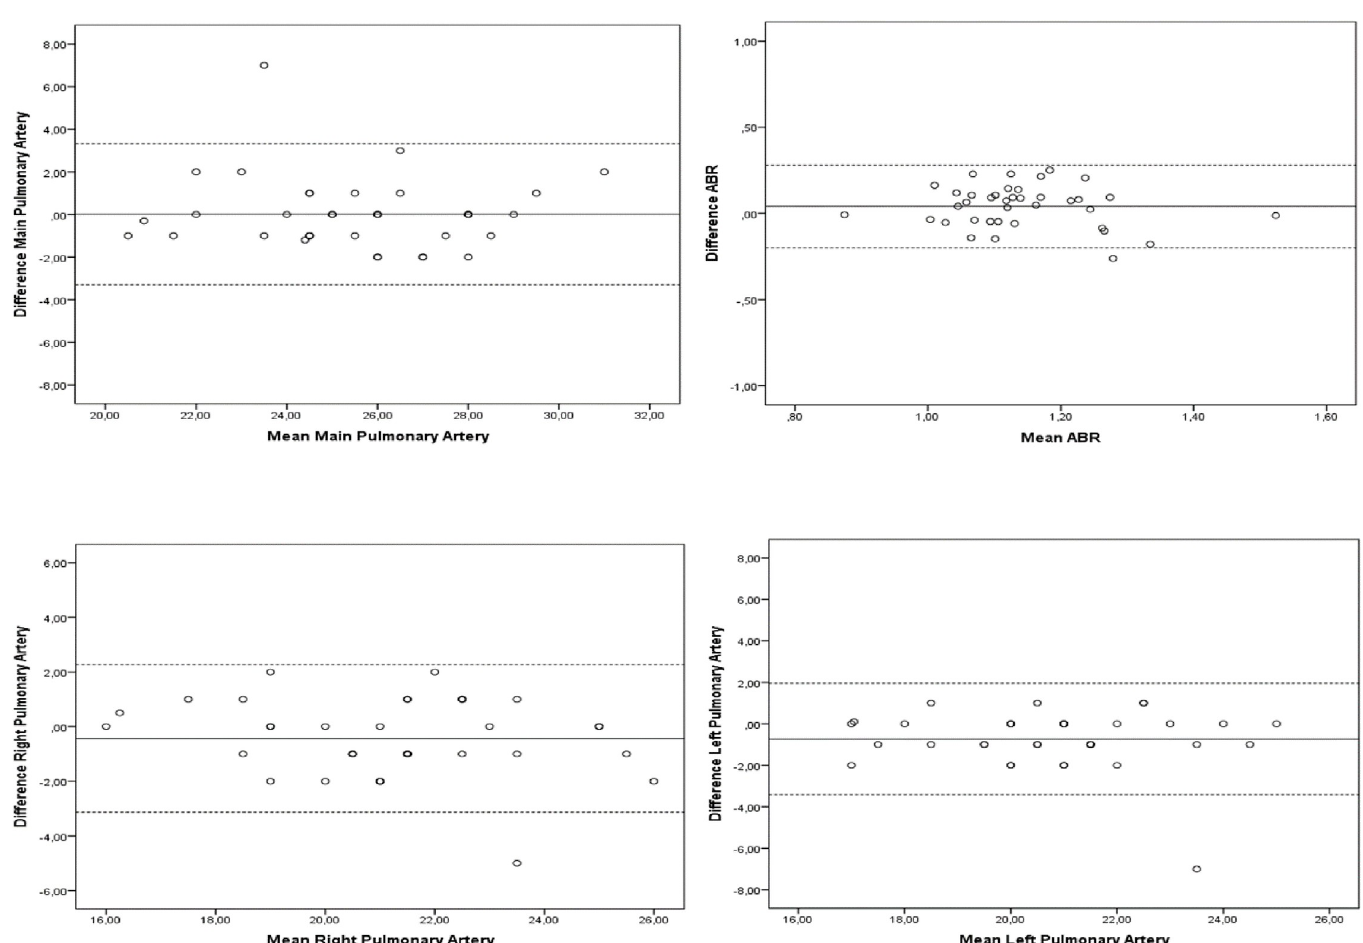
Fig 4. Intraobserver limits of agreement. Intraobserver limits of agreement with the Bland and Altmann technique.